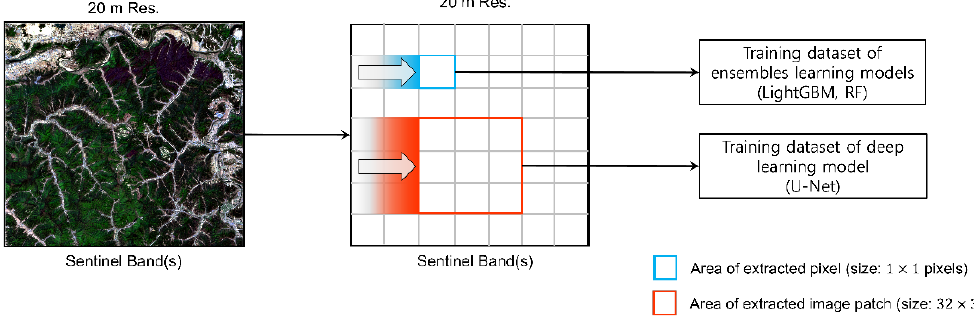
Figure 2. Input data characteristics according to machine learning models.